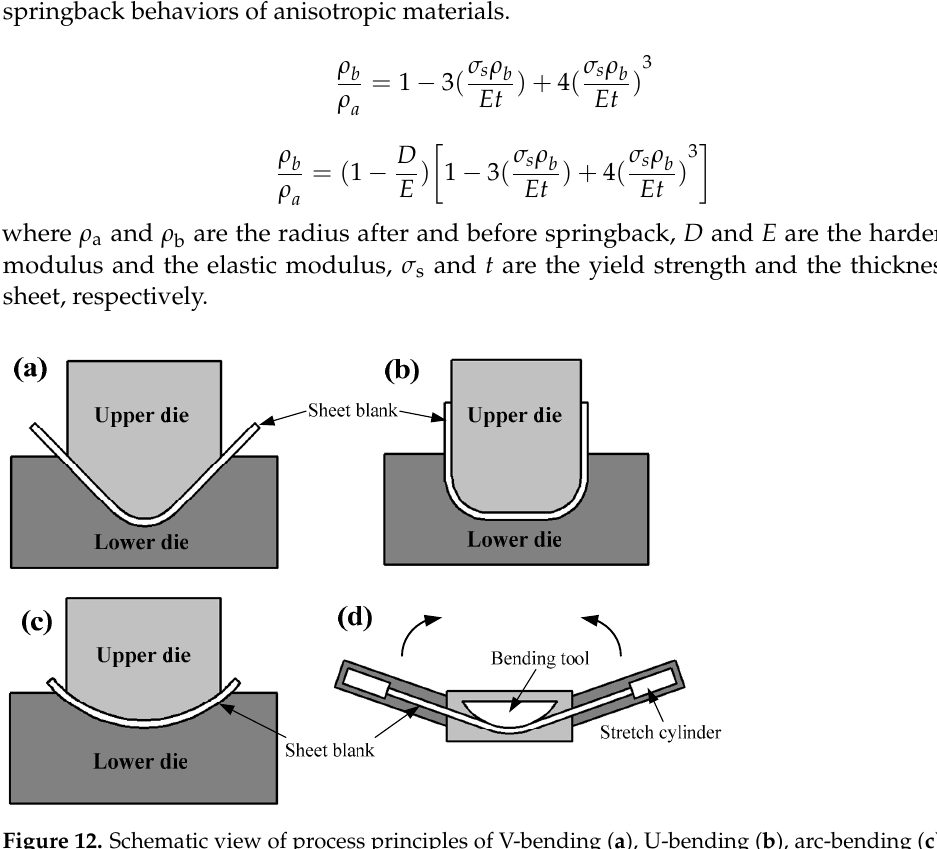
Figure 12. Schematic view of process principles of V-bending ( a ), U-bending ( b ), arc-bending ( c ) and stretch-bending ( d ).